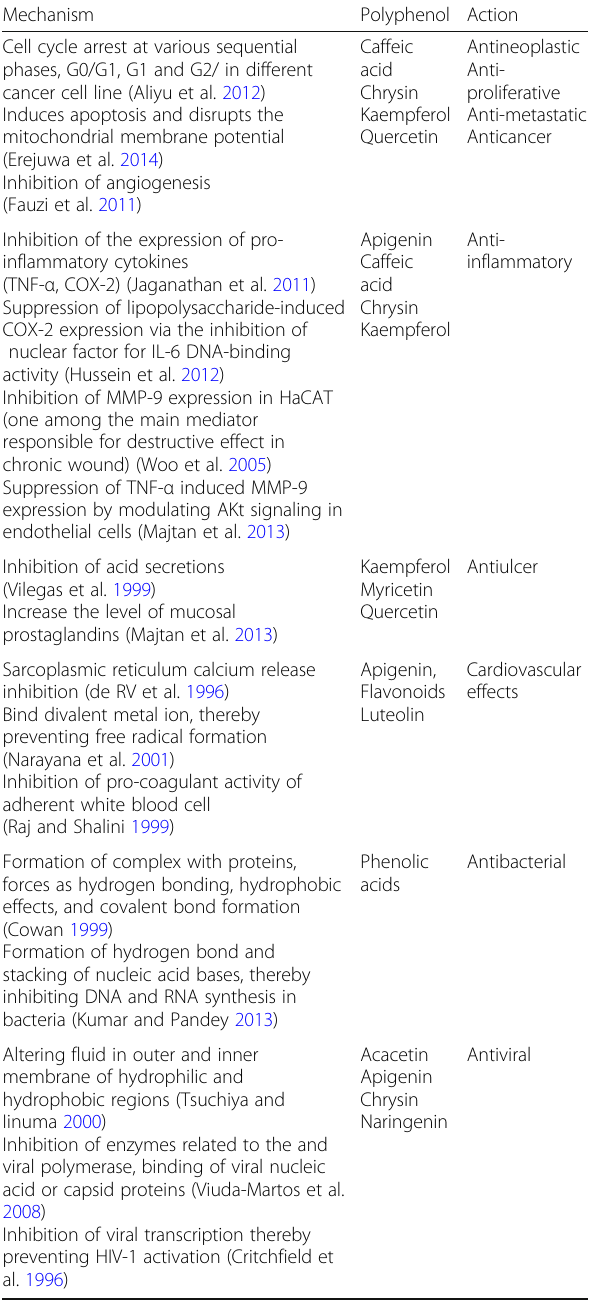
Table 3 The polyphenols mechanisms of action against human diseases Mechanism Polyphenol Action Cell cycle arrest at various sequential phases, G0/G1, G1 and G2/ in different cancer cell line (Aliyu et al. 2012) Induces apoptosis and disrupts the mitochondrial membrane potential (Erejuwa et al. 2014) Inhibition of angiogenesis (Fauzi et al. 2011) Inhibition of the expression of pro- inflammatory cytokines (TNF- α , COX-2) (Jaganathan et al. 2011) Suppression of